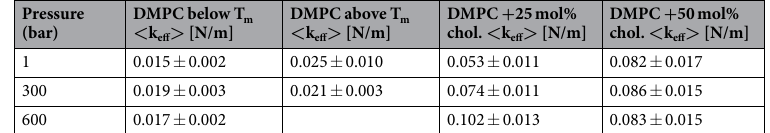
Table 2. Effective force constants calculated for DMPC + cholesterol at three HHP values and two different sterol concentrations. The values for DMPC are taken from 31 . We did not evaluate the force constant for DMPC above T m at 600 bar, as we had only two experimental points for doing